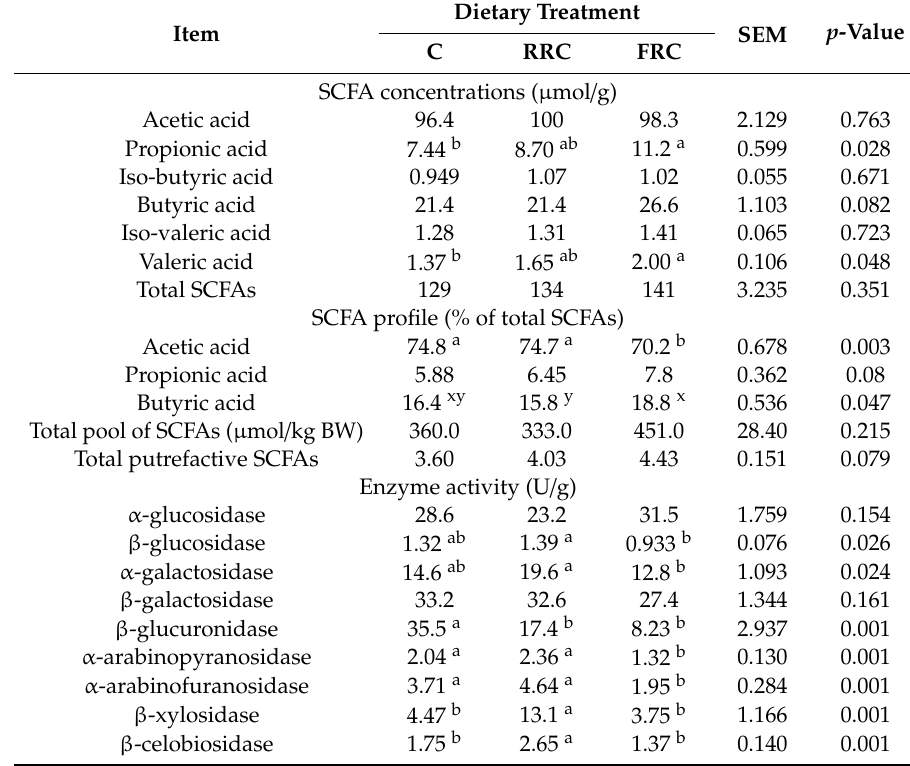
Table 4. Concentrations of short-chain fatty acids (SCFAs) and activities of selected bacterial enzymes in the cecal digesta of turkeys fed a control diet (C) and diets containing raw rapeseed cake (RRC) or fermented rapeseed cake (FRC) from 1 to 112 days of age 1